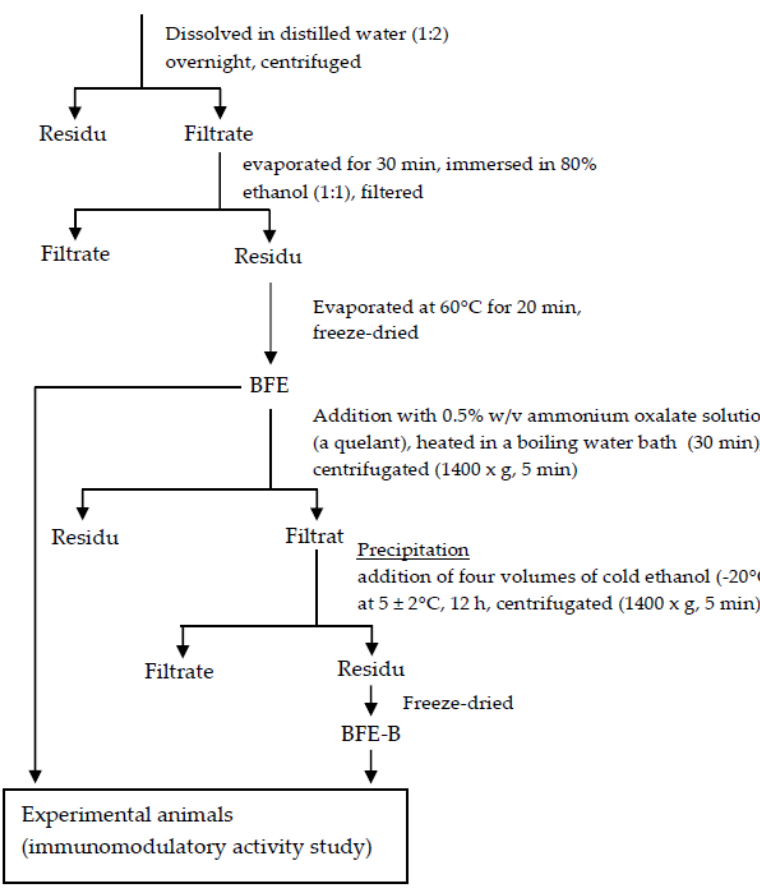
Figure 1. Preparation of water-soluble fibers of P. erosus tubers.